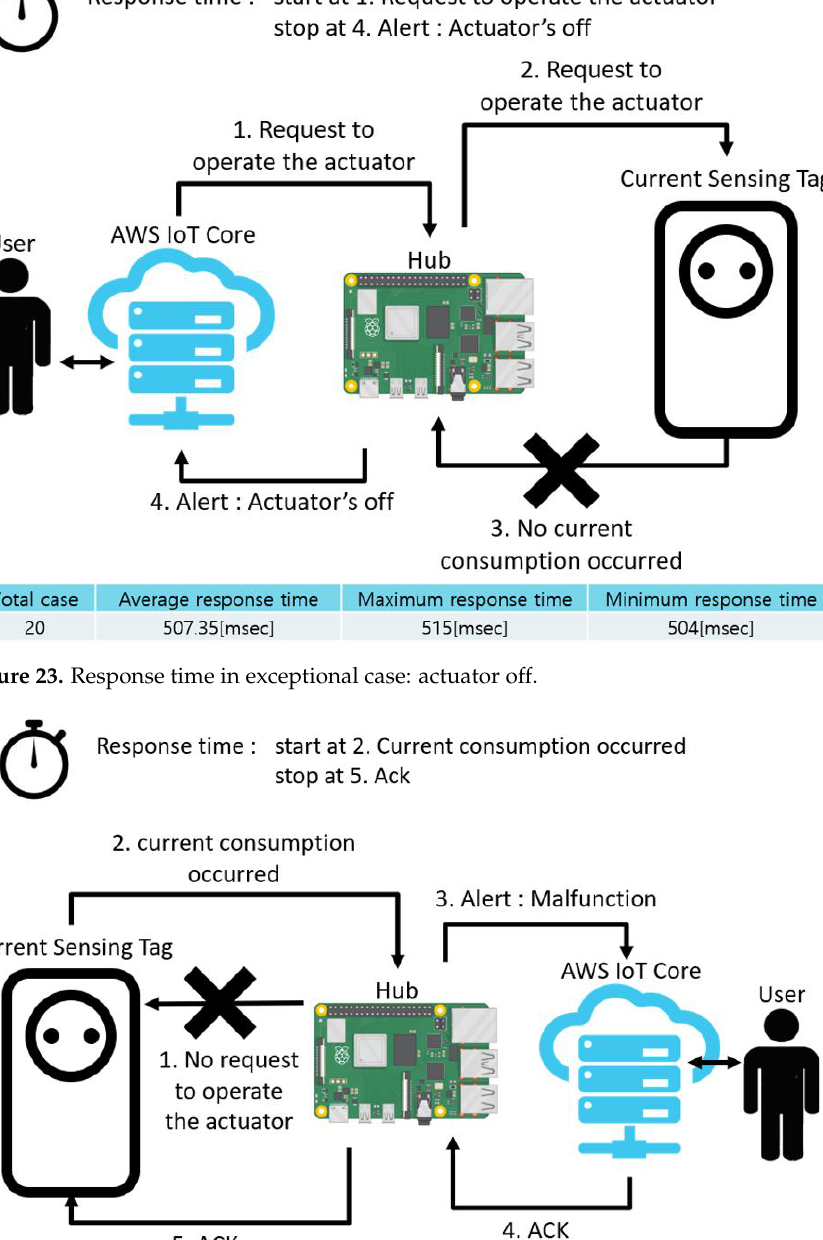
Figure 24. Response time in exceptional case: malfunction.